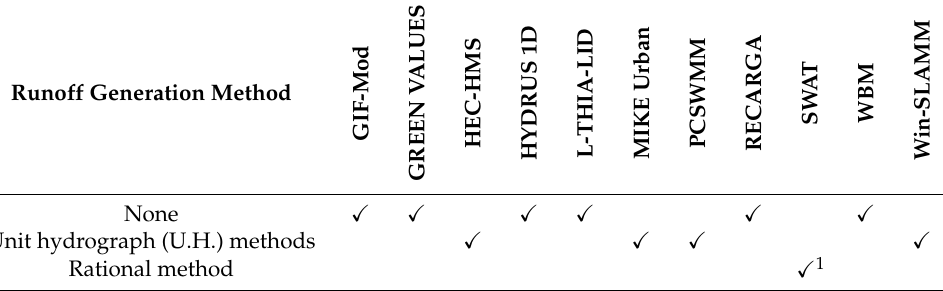
Unit hydrograph (U.H.) methods Rational method